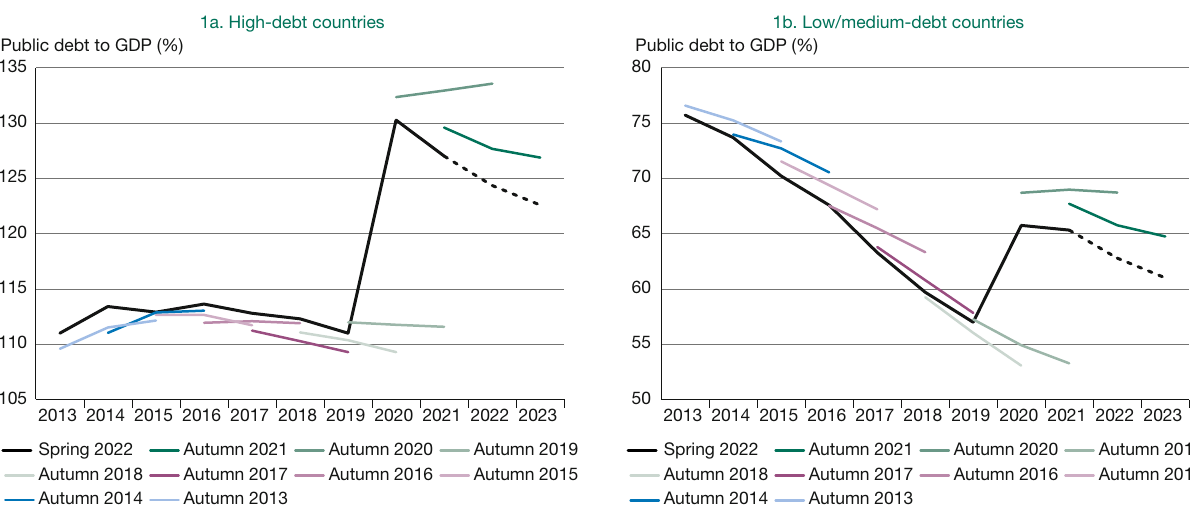
Government debt paths in euro area countries – forecasts and